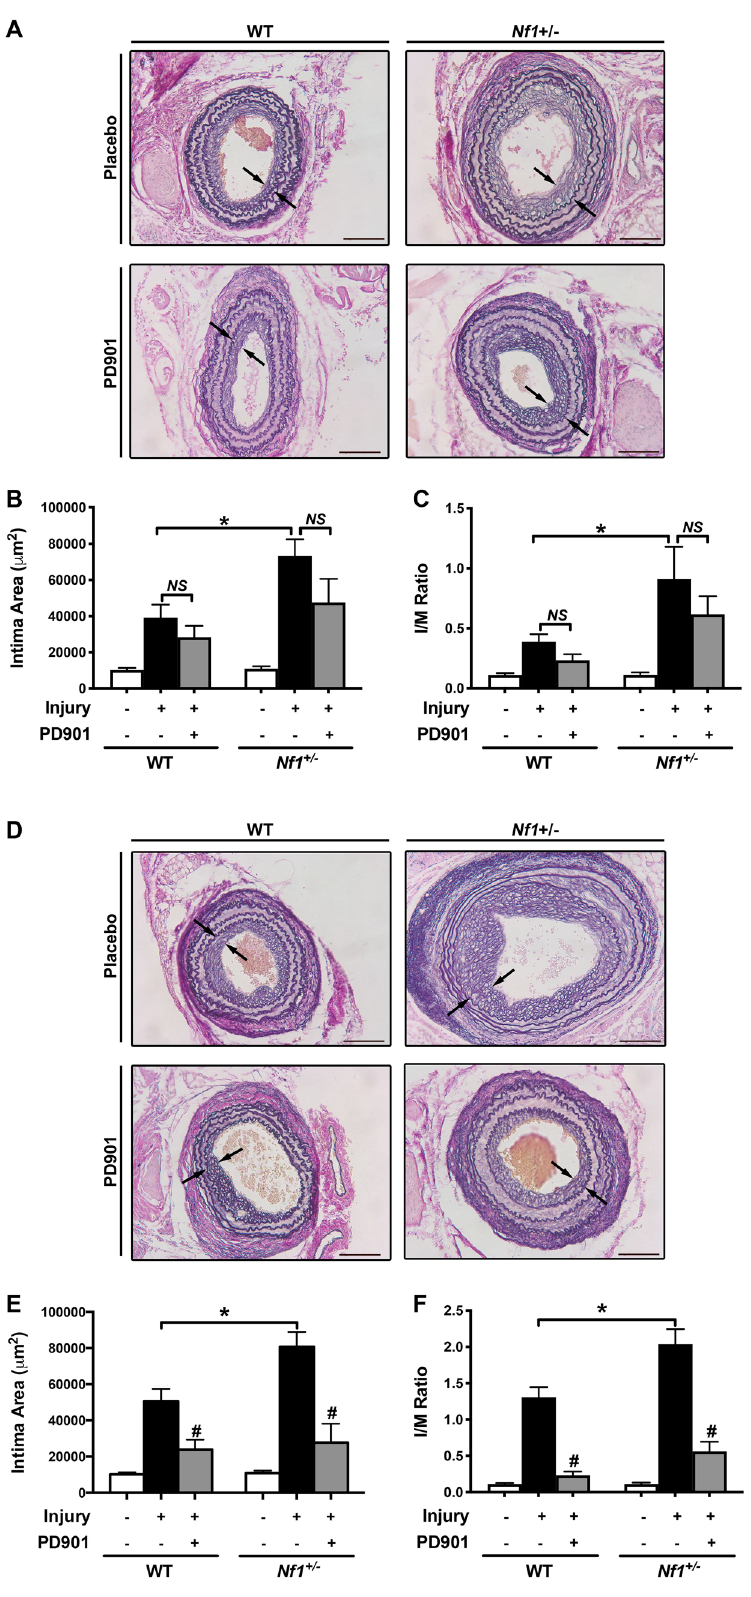
Figure 7. Mature, but not early neointima formation is sensitive to MEK inhibition ( A–F ) Representative photomicrographs ( A and D ) and quantification of intima area ( B and E ) and I/M ratio ( C and F ) of injured carotid arteries from WT and Nf1 +/– mice treated with either placebo or PD901 for 7 days ( A–C ) or 14 days ( D–F ) Data represent the mean intima area ( B and E ) or I/M ratio ( C and F ) of 3 arterial cross Sects. (400, 800, and 1200 μm proximal to the ligation) ± SEM, n = 8–10 per group. * P < 0.05 for WT injured with placebo treatment versus Nf1 +/– injured with placebo treatment. #P < 0.01 for injured with placebo treatment versus WT and Nf1 +/– injured with 5 mg/kg/day PD901 treatment. Analysis by 2-way